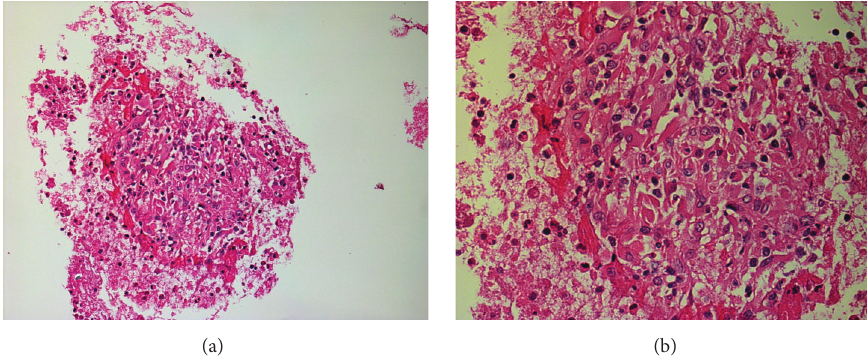
Figure 3: The histological finding of hematoxylin and eosin staining. (a) Low power sections (100x) and (b) high power section (400x) revealed mixed population of lymphoid cells. In addition, there are aggregates of epithelioid cells, forming granulomas; some showed central necrosis occasional multinucleated giant cells are also seen. On immunohistochemistry, the lymphoid cells are a mixture of both B and T lymphocytes forming germinal centers. No Reed-Sternberg cells are